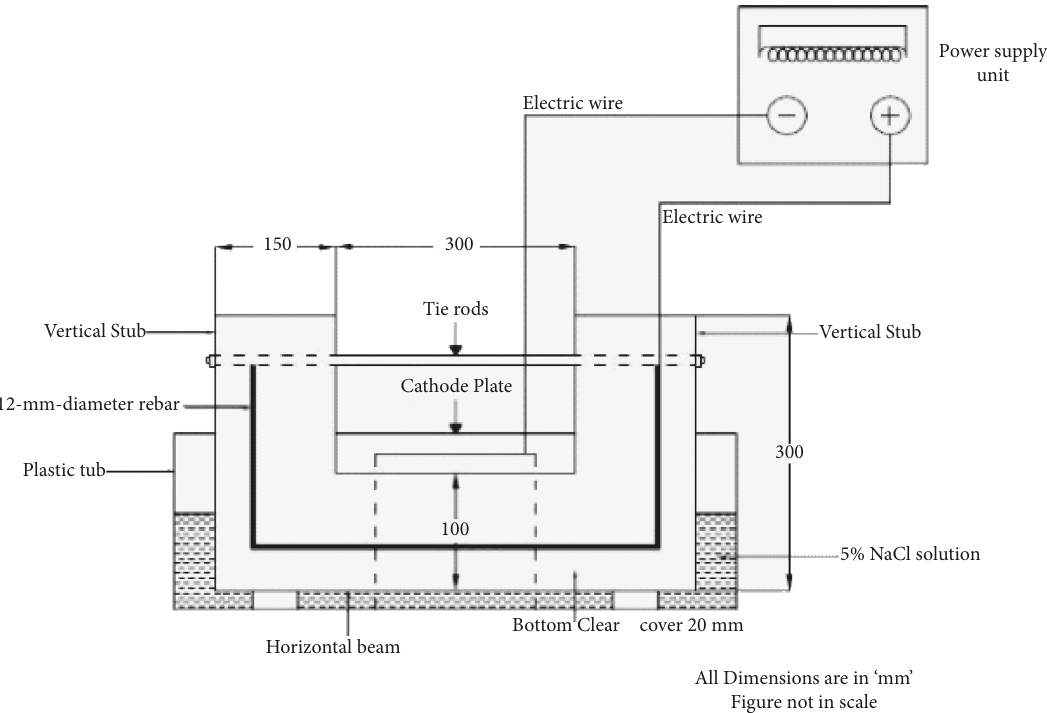
Figure 4: Layout of accelerated corrosion test of U-shaped